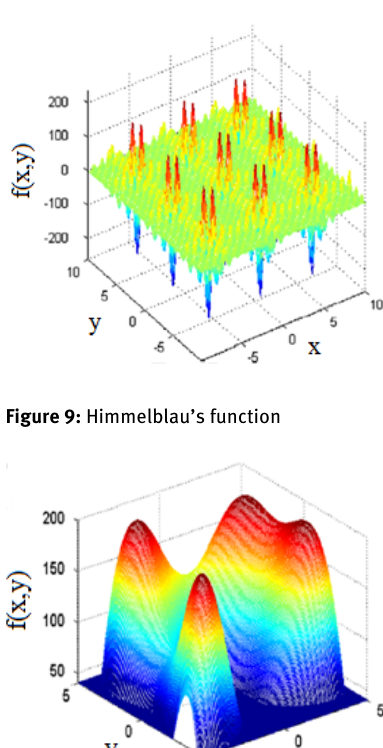
Figure 8: Inverted Shubert function